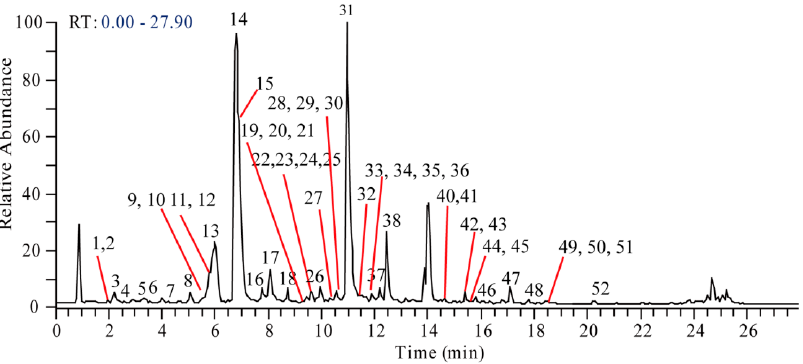
Figure 1. The total ion chromatogram (TIC) of the S.acutum extract. Table 1. Retention time, accurate mass data, and identification of alkaloids from the S.acutum. No.